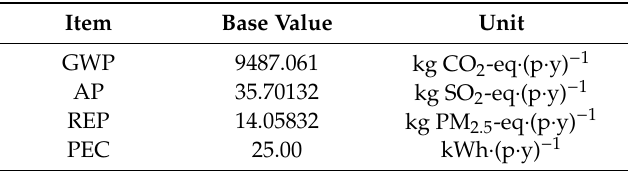
Table 19. Standardized base values for environmental impact